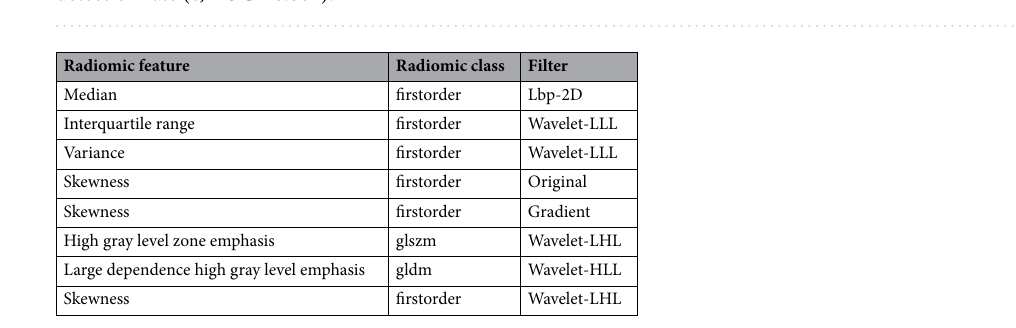
Figure 5. Receiver operating characteristic (ROC) curves of MRI model ( a , AUC = 0.805), diagnostic efficiency of two neuroradiologists ( b , the AUC of Reader 1 = 0.756, the AUC of Reader 2 = 0.545), and ADC map detection rate ( c , AUC = 0.881).